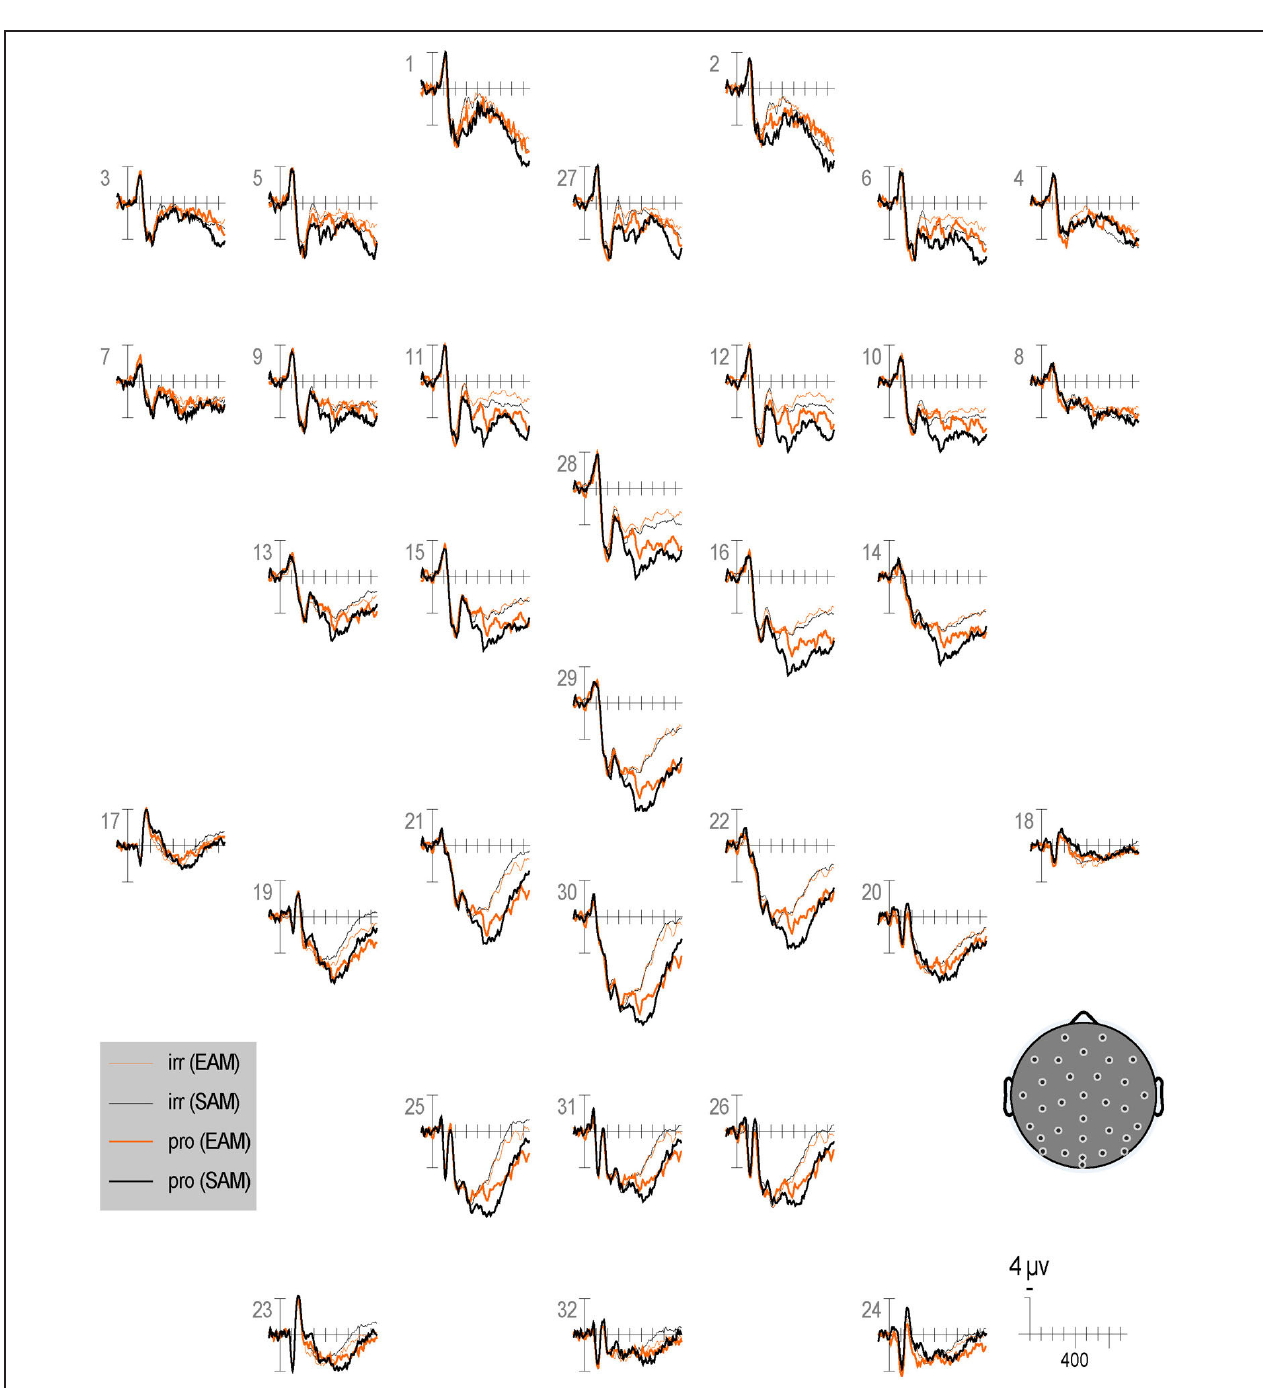
FIGURE 6 | Grand average ERPs elicited by irrelevants (thin solid lines), probes (thick solid lines) in the semantic (black lines) and episodic (red lines) autobiographical conditions in the first half of trials. ERPs are